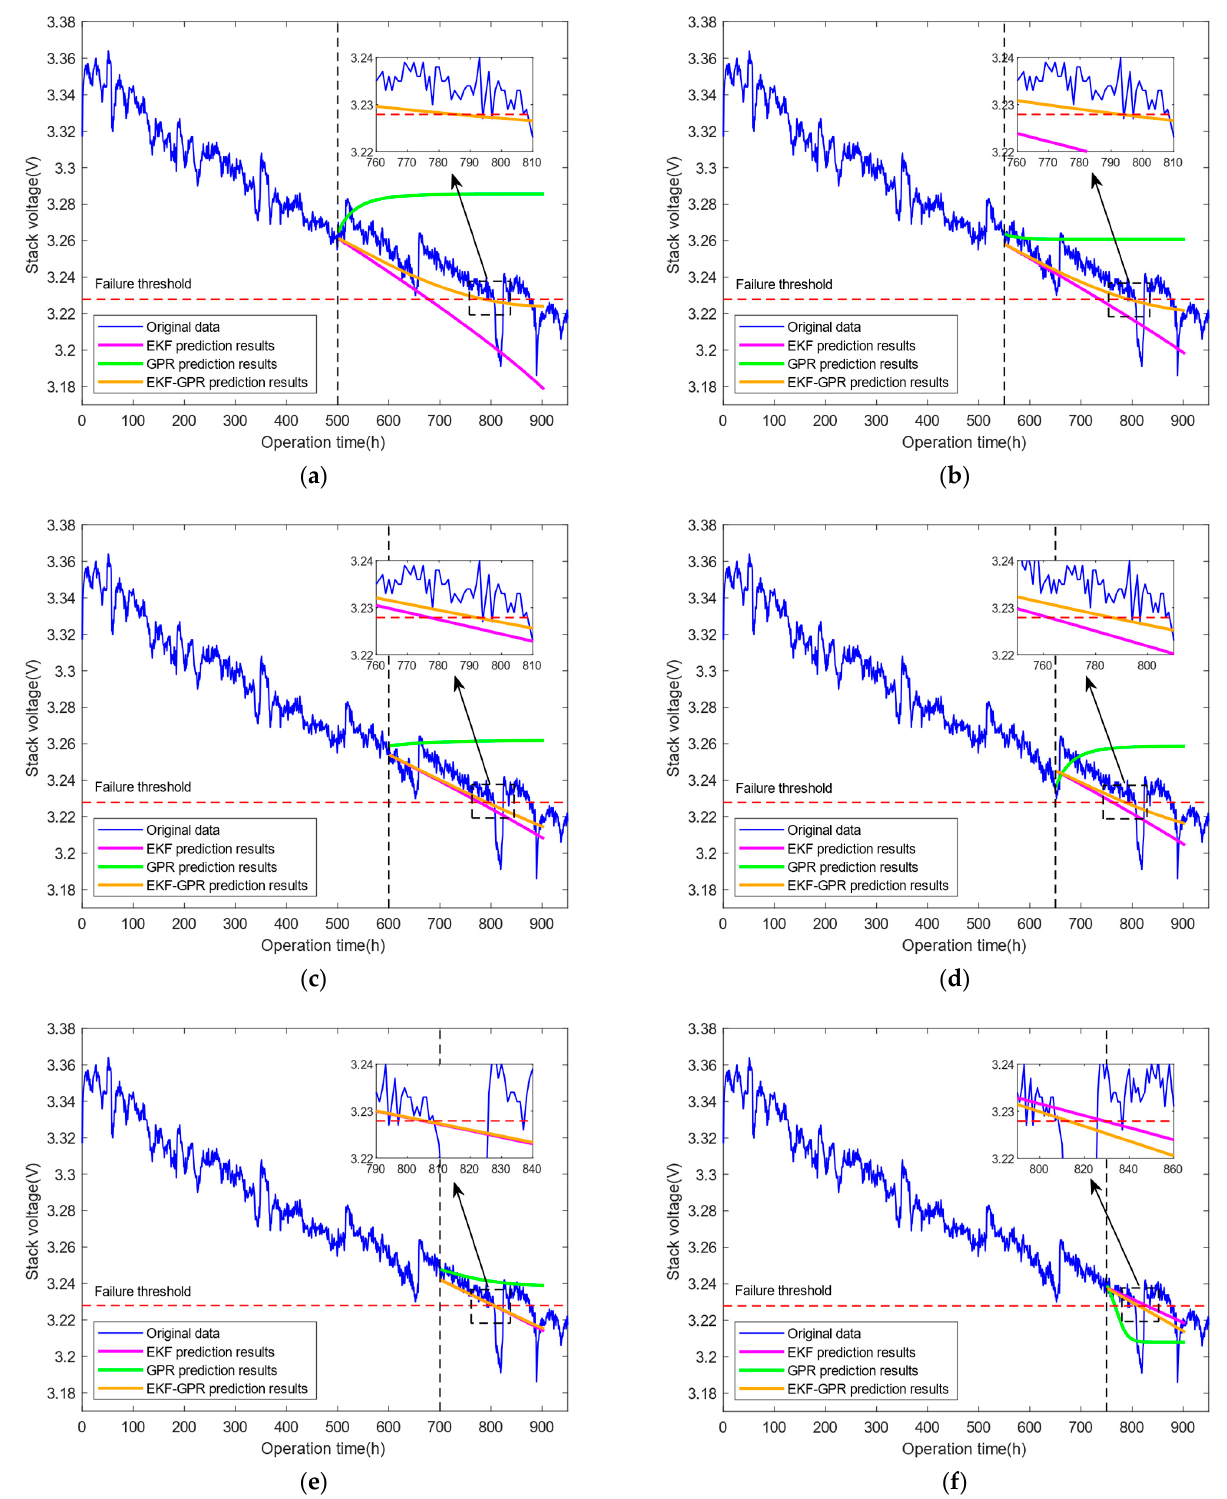
Figure 8. Prediction performance of the EKF-GPR model at different training stages: ( a ) TP at 500 h; ( b ) TP at 550 h; ( c ) TP at 600 h; ( d ) TP at 650 h; ( e ) TP at 700 h; and ( f ) TP at 750 h.